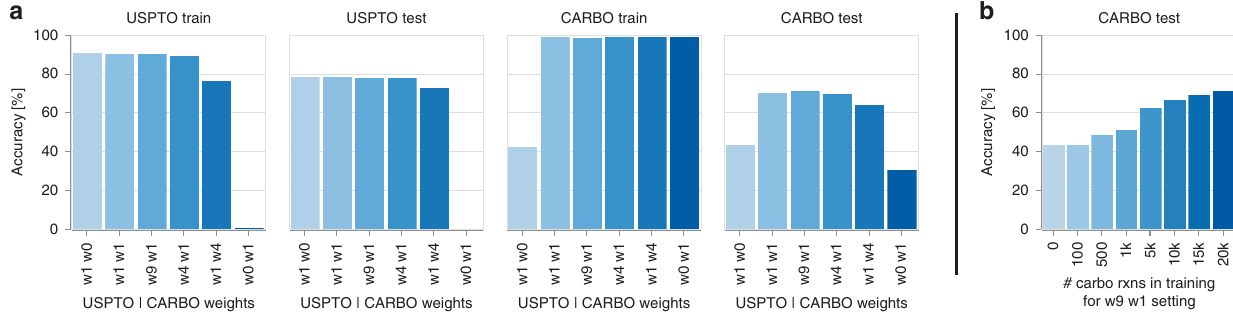
Fig. 1 Molecular Transformer model and data scenarios. Sequence-2-sequence prediction of carbohydrate reactions and the two transfer learning scenarios, namely, multitask and sequential training.